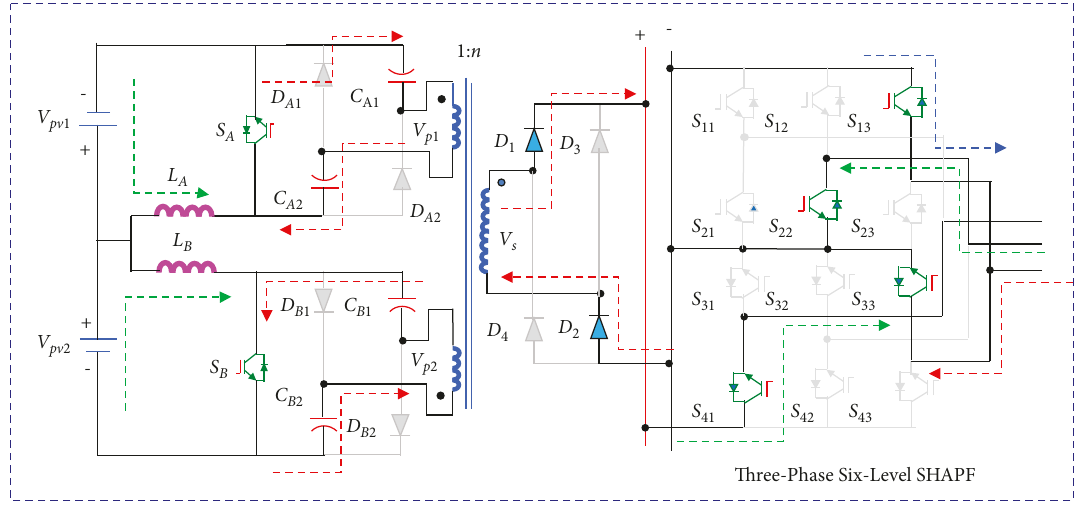
Figure 5: Equivalent circuit of mode 1